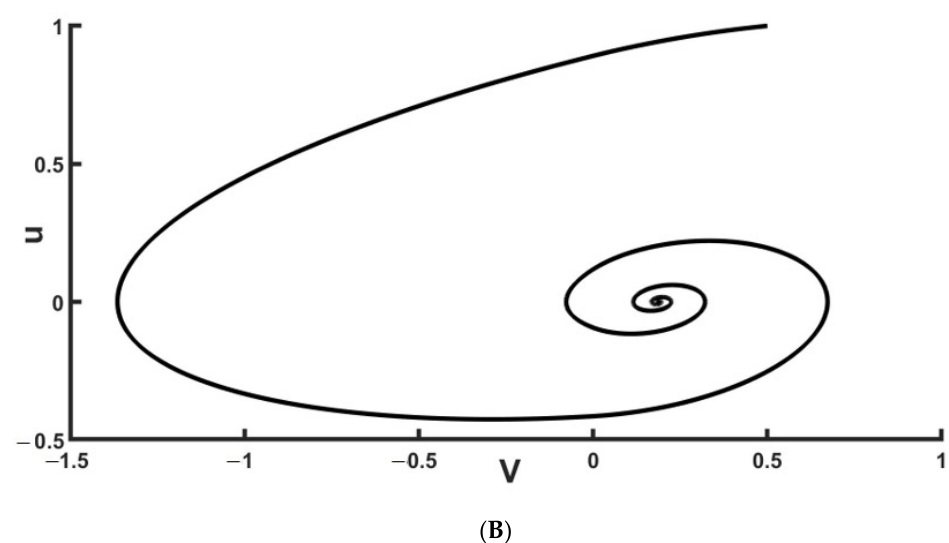
Figure 7. Results of numerical simulation of damped oscillations: ( A ) time series u and v , ( B ) phase portraits η = 0.48, ε = 0.24. Detailed information about the receipt of these figures is contained in Supplementary Materials.